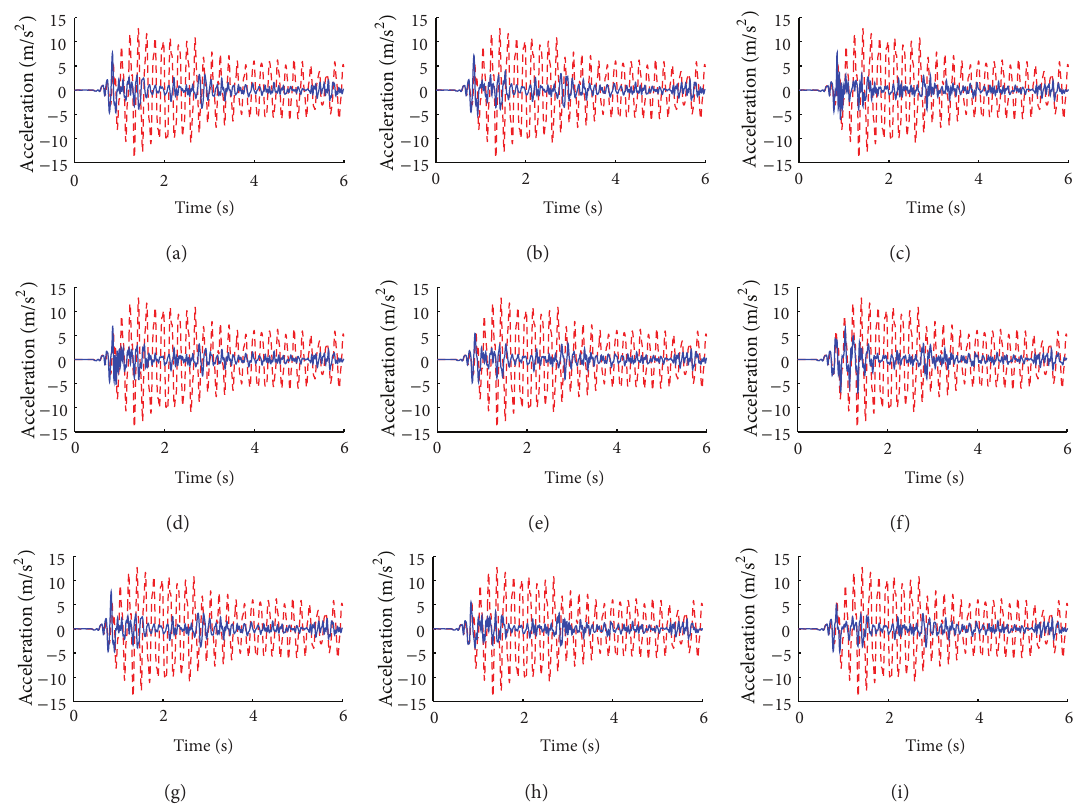
Figure 8: Controlled and uncontrolled (red dashed line) acceleration response of the third floor: (a) passive on, (b) Lyapunov controller (A), (c) Lyapunov controller (B), (d) quasi-bang-bang controller, (e) decentralized bang-bang controller, (f) modulated homogenous friction controller, (g) maximum energy dissipation controller, (h) clipped-optimal controller, and (i) proposed